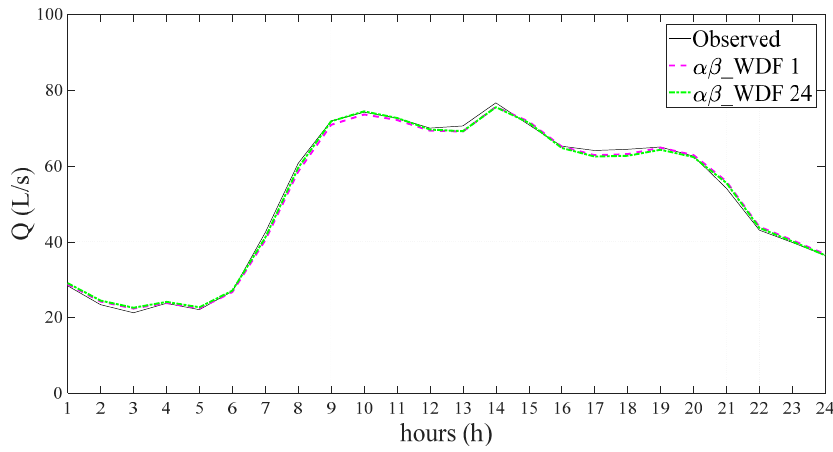
Figure 8. Comparison between the observed water demand pattern for a generic day in the year 2000 (23 January) and the 1- and 24-h-ahead forecasts provided by the αβ _WDF model. Q is the discharge flowing in the main pipe that connects the tank to the water distribution system, thus representing the total water demand of the network.